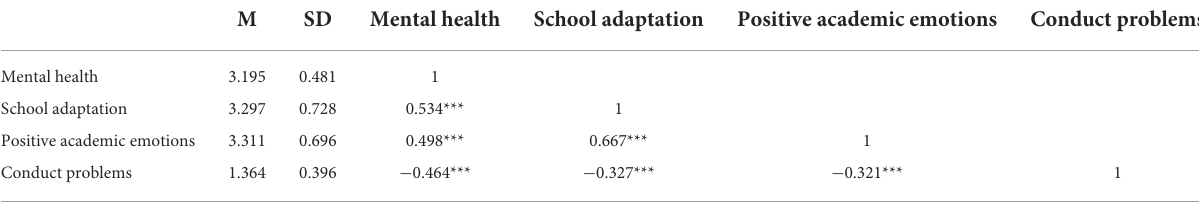
TABLE 2 Correlation analysis of school adaptation, mental health, positive academic emotions, and conduct problems among immigrant adolescents. M